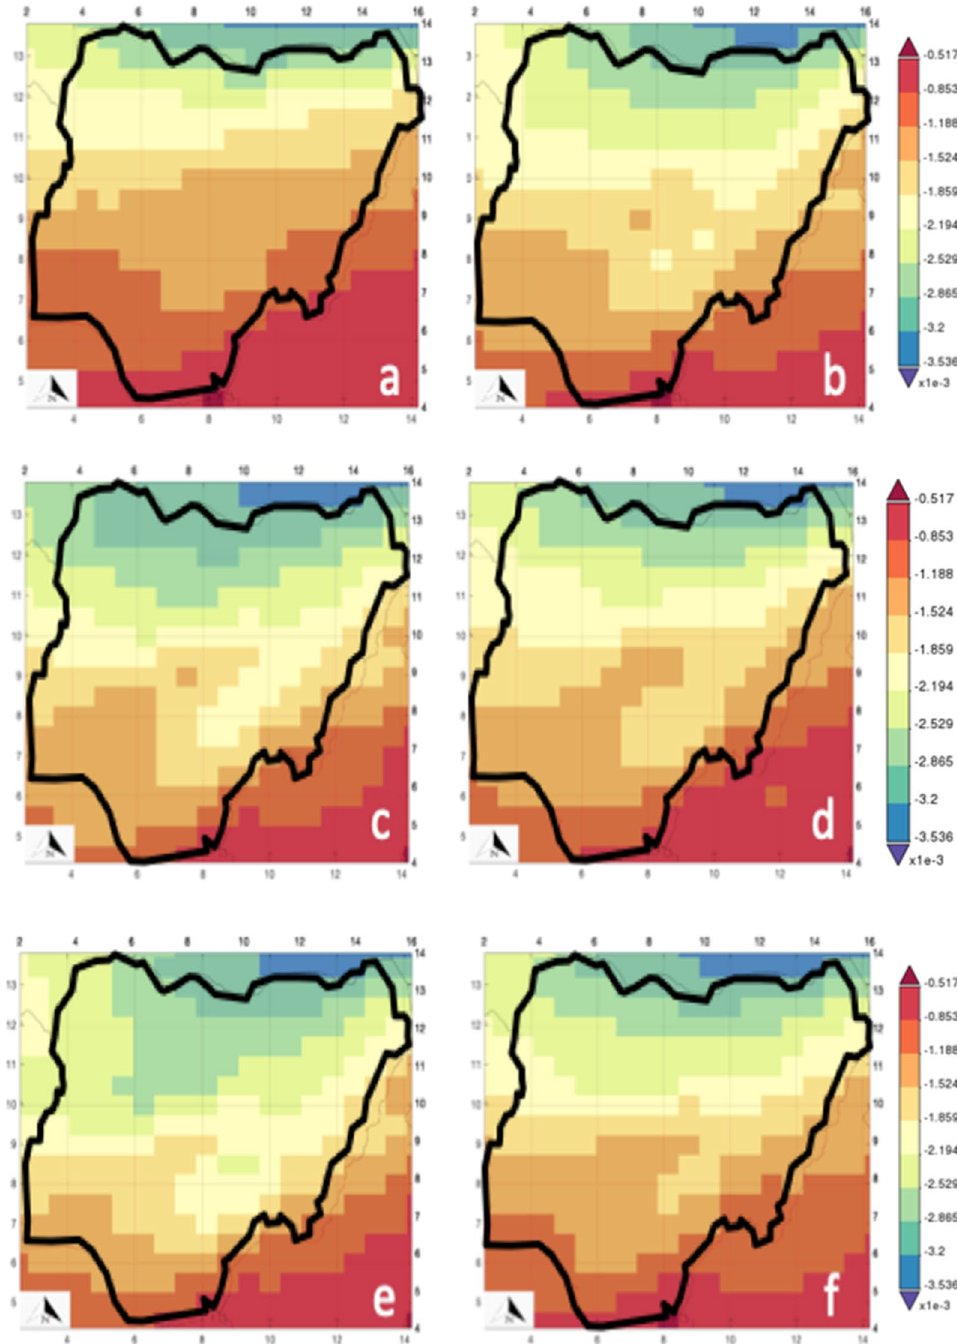
Figure 7. Dust column u-wind mass flux ( a ) 2010, ( b ) 2014, ( c ) 2015, ( d ) 2016, ( e ) 2017 ( f )